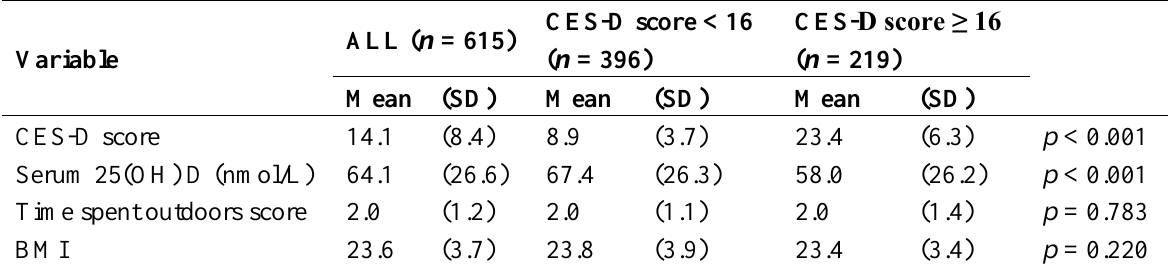
Table 2. Participant characteristics by presence of depressive symptomatology (CES-D score below 16 vs. 16 and over).